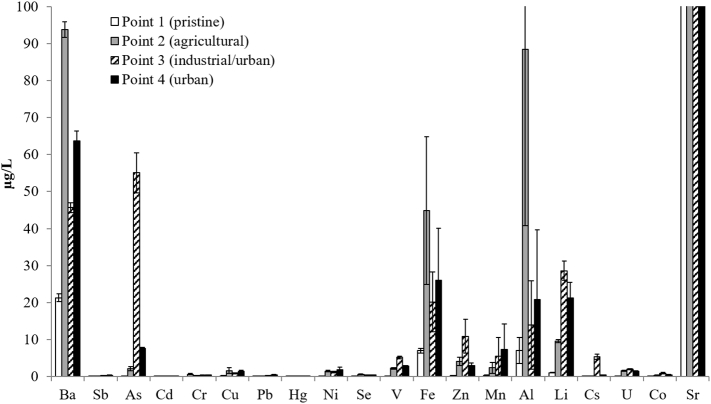
Average concentrations of the metals (μg/L) measured in the five samplings at the four sampling points (1, 2, 3 and 4) of the river. Out of scale values of Sr are indicated on the right (Point 1: 304 μg/L; Point 2: 800 μg/L; Point 3: 2138 μg/L; Point 4: 1411 μg/L). The vertical bars represent the standard errors.